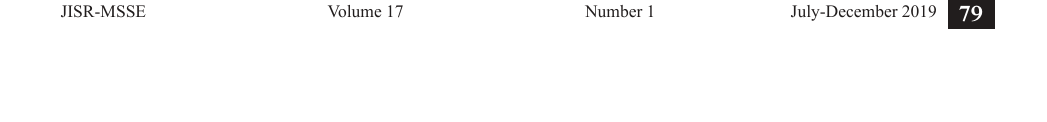
Figure 5. Rule viewer for a case in an illustrative